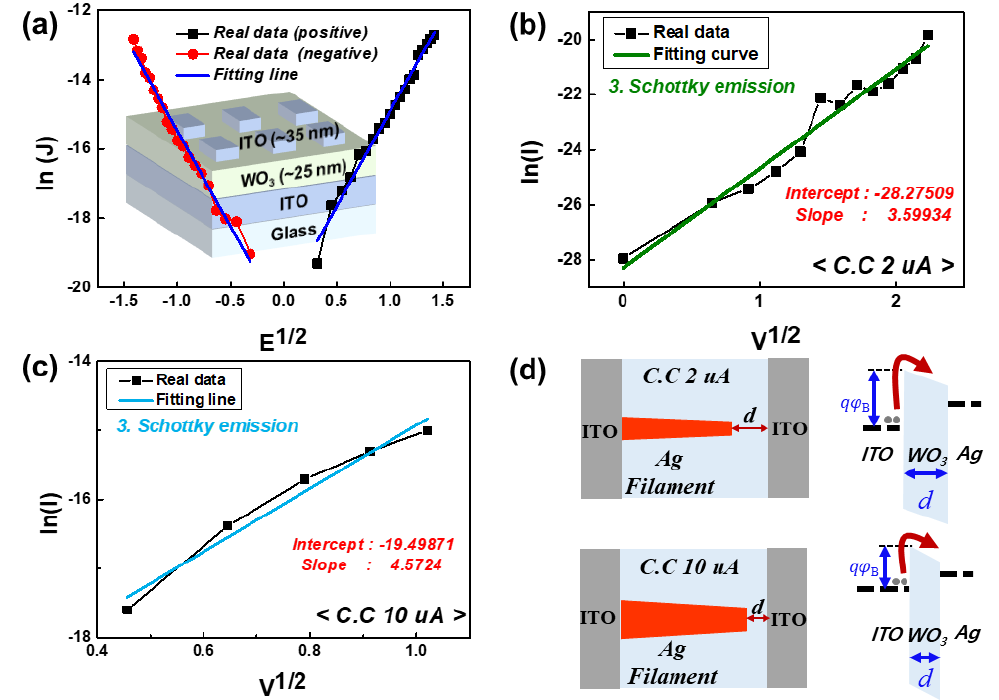
Figure 5. ( a ) Fit I–V curve of the symmetric structured device to demonstrate the rectifying behavior. The inset shows the structure of the fabricated device. The curve is well fit by the Schottky emission in both the positive- and negative-bias region. This means that the Schottky barrier is formed at the interface between the ITO and WO 3 layers. For ( b ) 2 µ A and ( c ) 10 µ A current compliance, intercepts and slopes are extracted, from which the Schottky barrier height and width can be derived using Equations (4) and (5). ( d ) From the results, the operation mechanisms of the 2 µ A and 10 µ A cases can be depicted by the Schottky barrier height and width d